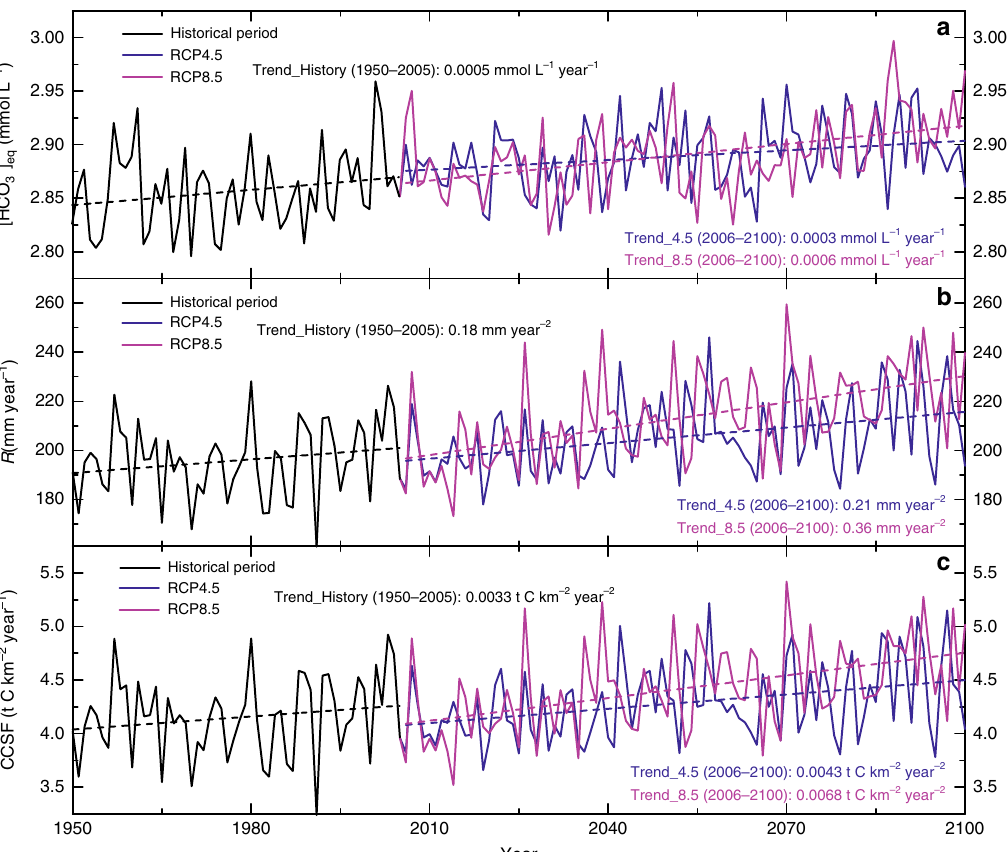
Fig. 1 Interannual changes in relevant variables. a [HCO 3 − ] eq , b R (runoff), and c CCSF (carbonate weathering carbon-sink fl ux) on global carbonate rock outcrops during the historical period (1950 – 2005) and the two future (2006 – 2100) scenarios (RCP4.5 and RCP8.5). All the variables display increasing trends. The historical period (black line) has the lowest CCSF variation and RCP8.5 (purple line) has the highest, indicating the substantial response of CCSF to dramatic climate change and land-use